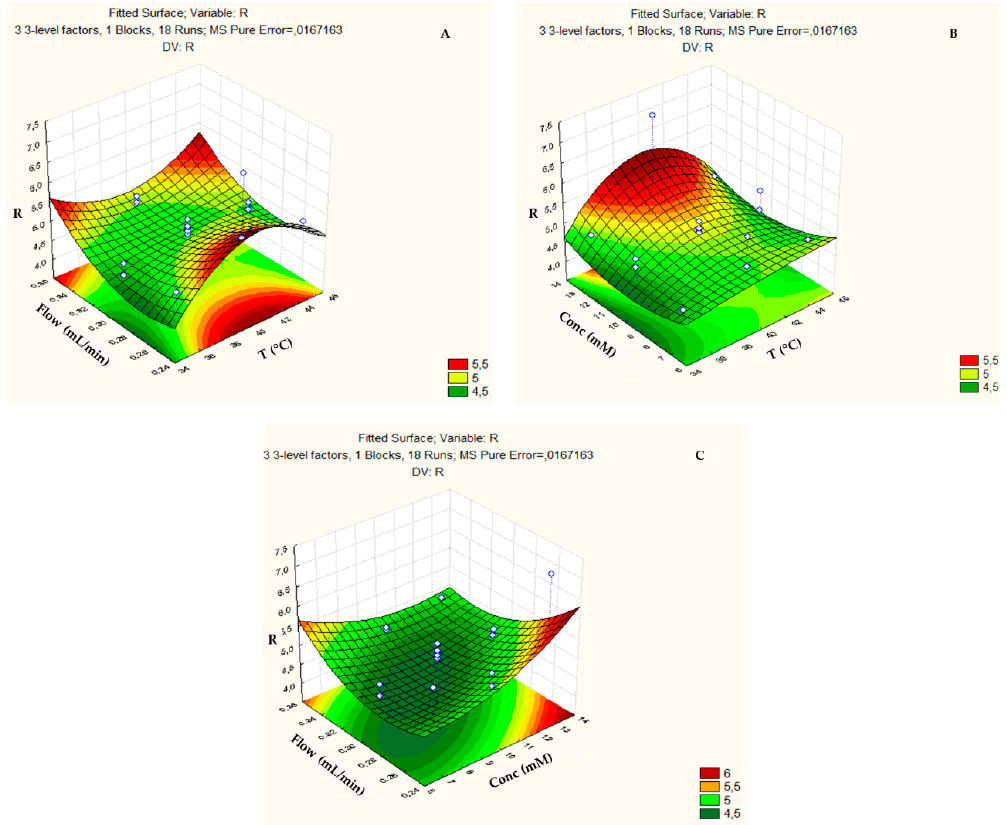
Figure 3. Three-dimensional response surface plot showing the effects of the mutual interactions between two independent variables ( a ) Flow and Temperature; ( b ) Concentration and Temperature; and, ( c ) Flow and Concentration on resolution (R) of the chromatographic analysis on the ZIC-p-HILIC column.